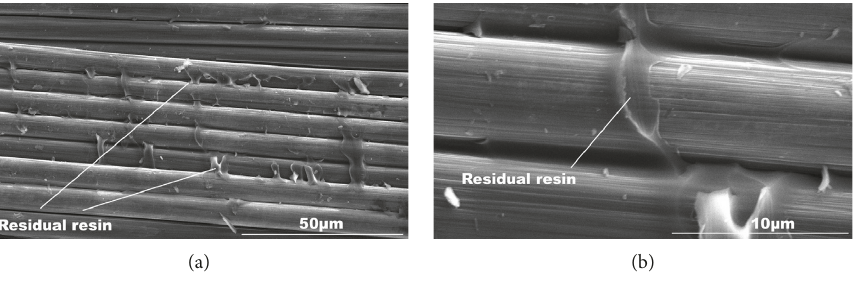
Figure 4: ESEM images of RF400 fibre (a: